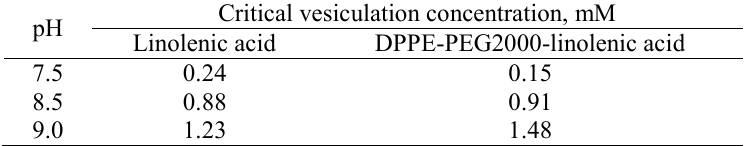
Table 1. Critical vesiculation concentration (CVC) of linolenate-linolenic acid vesicle and PEGylated linolenate-linolenic vesicle at various